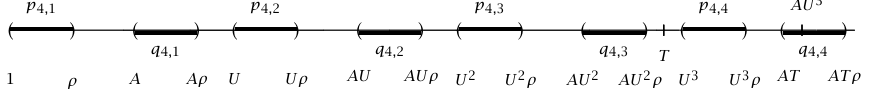
Figure 3.1 . The distributions F and G of Theorem 3.2, with n =